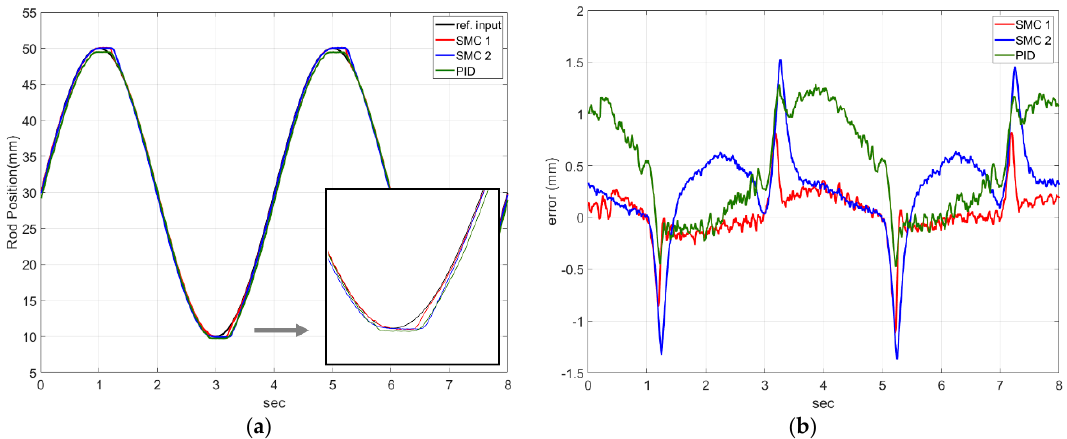
Figure 12. Comparisons of the experimental results: ( a ) is the position control performance of the SMC (sliding motor control) and the PID control, ( b ) is a comparison of errors.